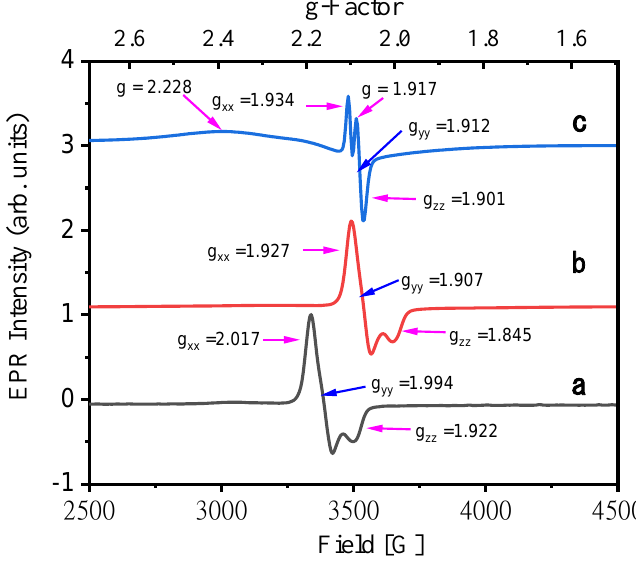
Figure 2. EPR spectra of 1 : ( a ) crystal at 77K, ( b ) crystal at 298K, and ( c ) solution in dichloromethane at 298 K. EPR settings: microwave frequency, 9.879 GHz; microwave power, 10.080 mW; number of scans, 1. Theoretical calculations used Becke’s three-parameter B3LYP for C, H, O, N, and Cl, and the LANL2DZ basis set for the element Ir used the package Gaussian 03. The atomic coordinates of the complexes were obtained directly from X-ray crystallography and used as the initial geometry for optimization. The metric parameters obtained from the X-ray structure and DFT calculations are in good agreement (Table 2), and the atomic coordinates (Angstroms) of complex 1 are listed in Supplementary Materials Table S1. The calculated single-molecular orbital (SOMO) of compound 1 is composed of 87.91% π (4cpbo) + 10.53% d(Ir) + 1.34% ( µ -O) + 0.3916% ( µ -Cl) (Figure 3). This is consistent with the EPR spectrum observation of the crystal of complex 1, where the unpaired electrons are delocalized to iridium, µ -O, µ -Cl, and two ligands 4cpbo. This delocalization stabilizes the structure of 1 and leads to the isolation of this compound. Table 2. Comparison of selected bond lengths (Å) and angles ( ◦ ) of 1 from crystallography and DFT